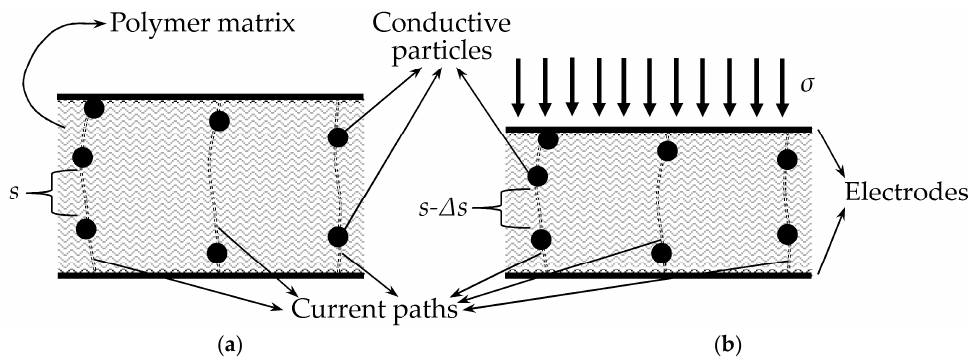
Figure 3. Sketch of a polymer composite with randomly spaced conductive particles and multiple current paths. ( a ) Unloaded polymer composite depicting a tunneling path of width s ; ( b ) Polymer composite under applied stress ( σ ) depicting a shortening in the tunneling path from s down to s- Δ s . The applied stress is exerted over the sensor electrodes causing compression in the polymer